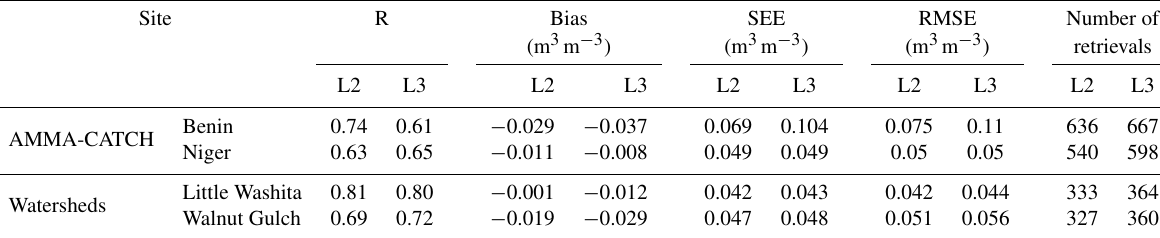
Table 7. Statistics of the in situ vs. SMOS L3SM and L2SM for descending